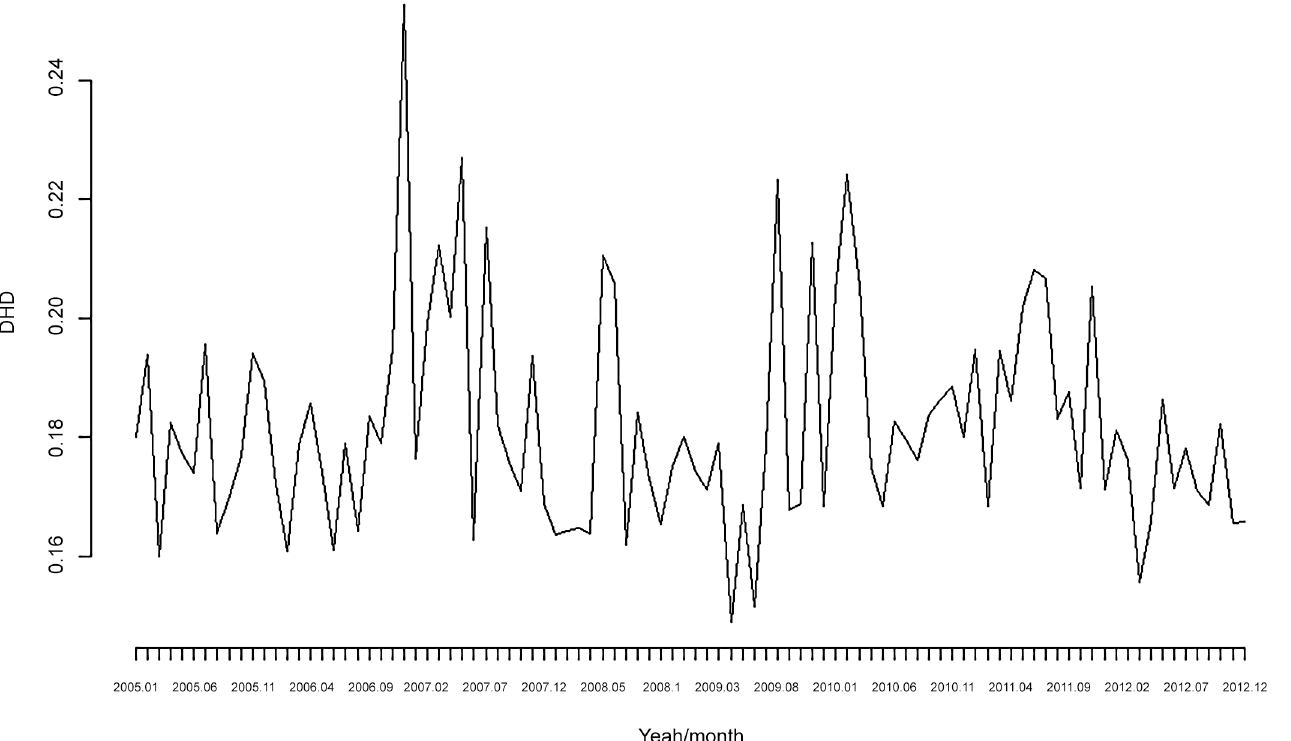
Fig 2. Consumption of psychotropic drugs. DDD per individual/month. Monthly data for the period 2005 – 2012.